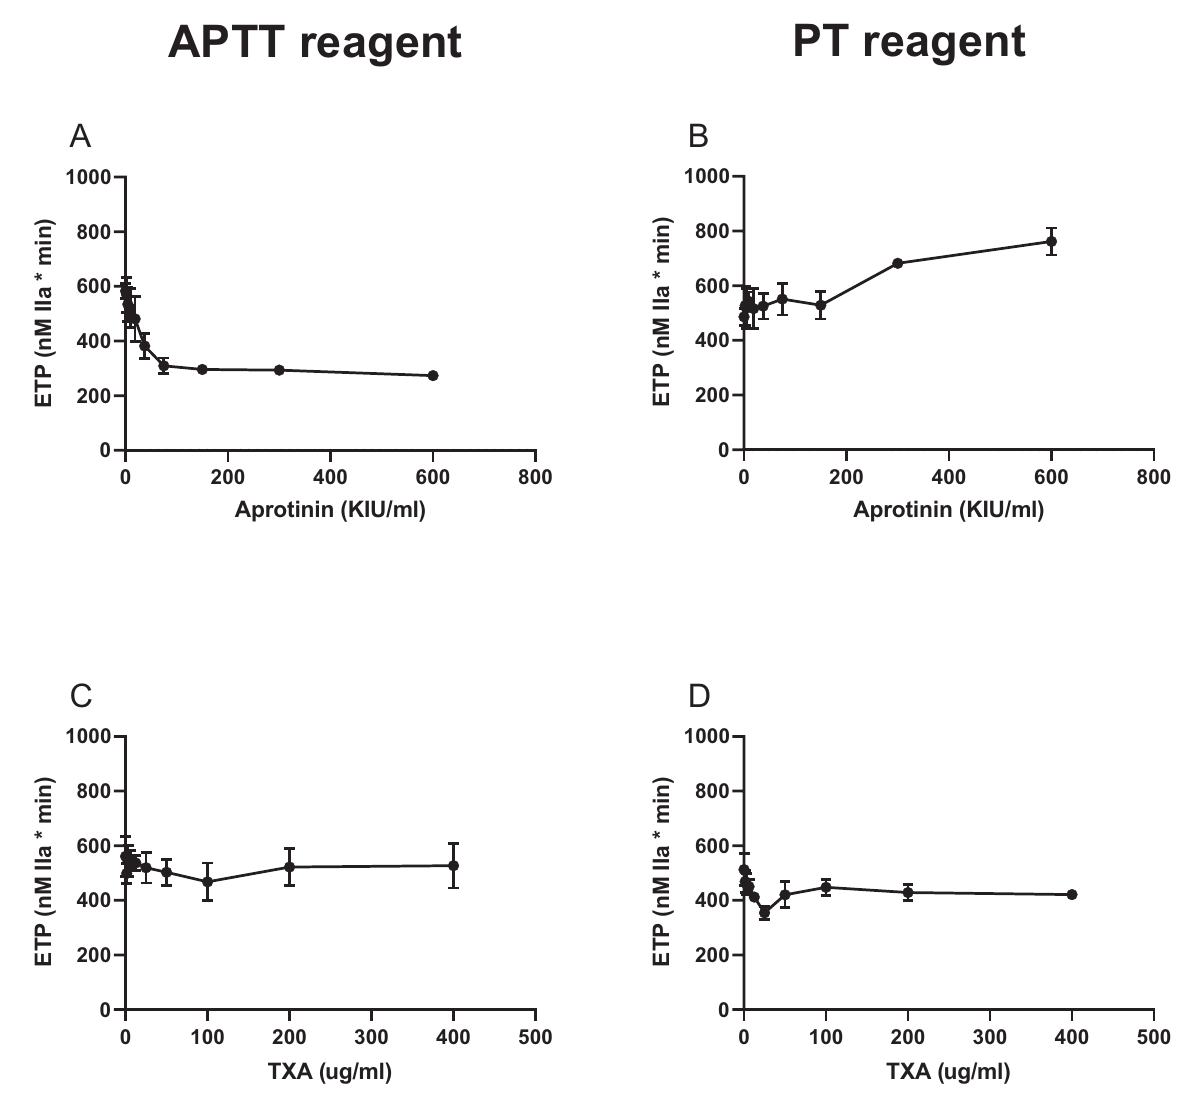
Fig. 4 Effects of aprotinin and TXA on the Endogenous Thrombin Potential (ETP) in the presence of soluble thrombomodulin. Aprotinin and TXA were added to pooled normal plasma in increasing concentrations and samples were subjected to thrombomodulin-modi fi ed calibrated automated thrombinography. Coagulation was initiated by a dilute APTT reagent ( A and C ) or a dilute PT reagent ( B and D ). Shown are mean ETP values derived from thrombin generation curves of 3 independent experiments. Error bars indicate standard